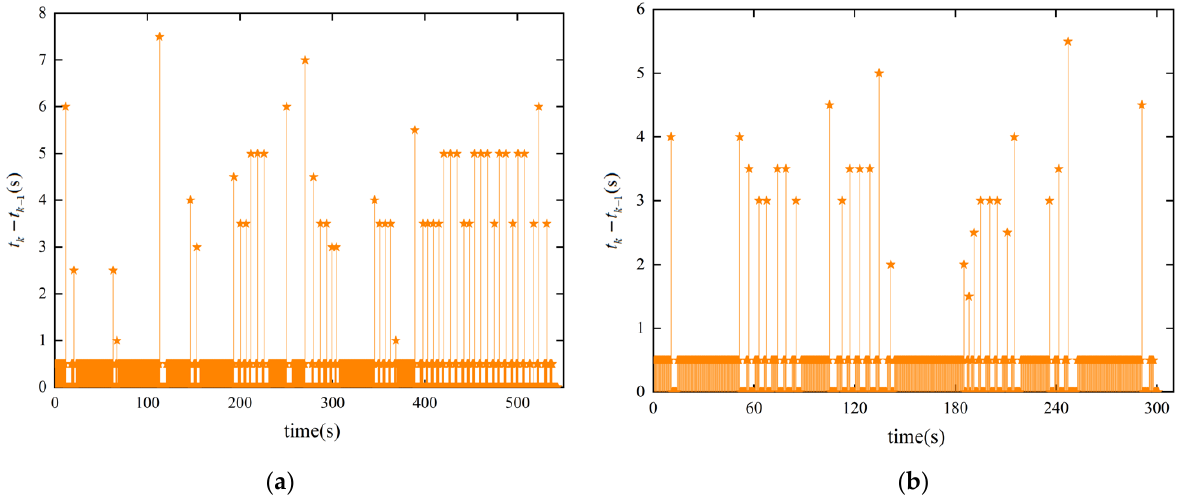
Figure 9. Performance of ETM strategy in paths 1 and 2: ( a ) performance of ETM strategy in path 1; ( b ) performance of ETM strategy in path 2.